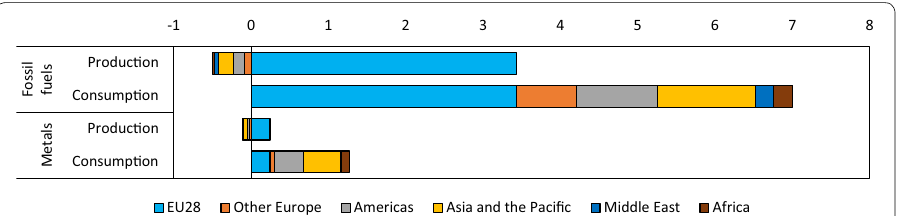
Fig. 3 EU28’s production and consumption of fossil fuels and metal ores in 2014 in Gt, used extraction, EXIOBASE 3.4, negative values are reflecting EU28’s exports with the regions being the destination of the exports, for consumption the regions are the regions of